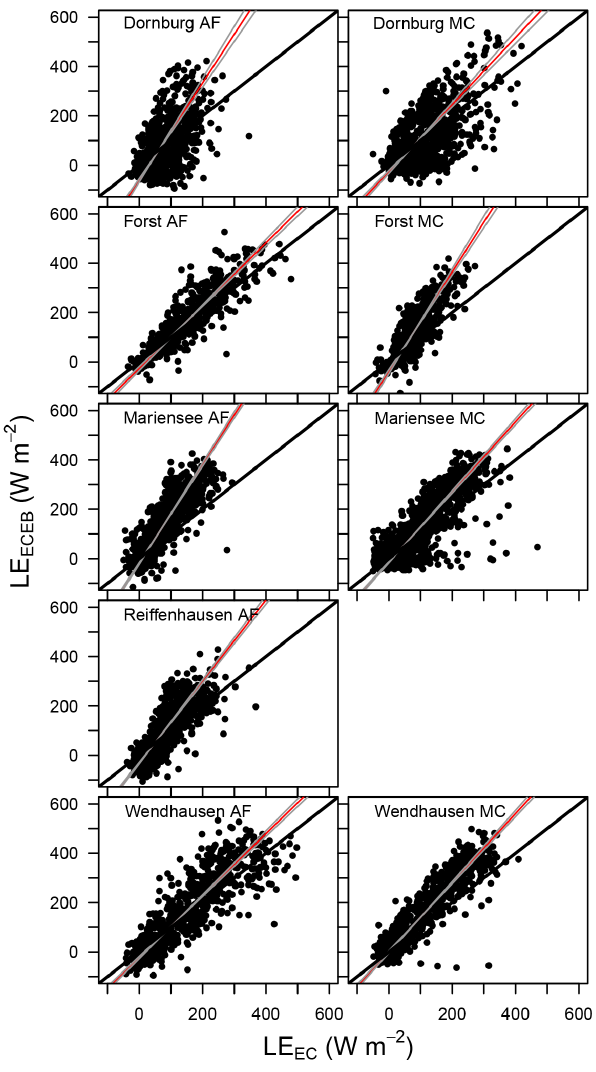
Figure C3. Scatter plot of LE EC-LC vs. LE EC for all sites. The red line denotes the best fit line, with grey lines as the ± 2 . 5% con- fidence interval lines, and the solid black lines corresponding to the 1:1 line. Data from Reiffenhausen MC are missing due to the unavailability of a campaign, and LE EC-LC from Mariensee AF is missing due to sensor